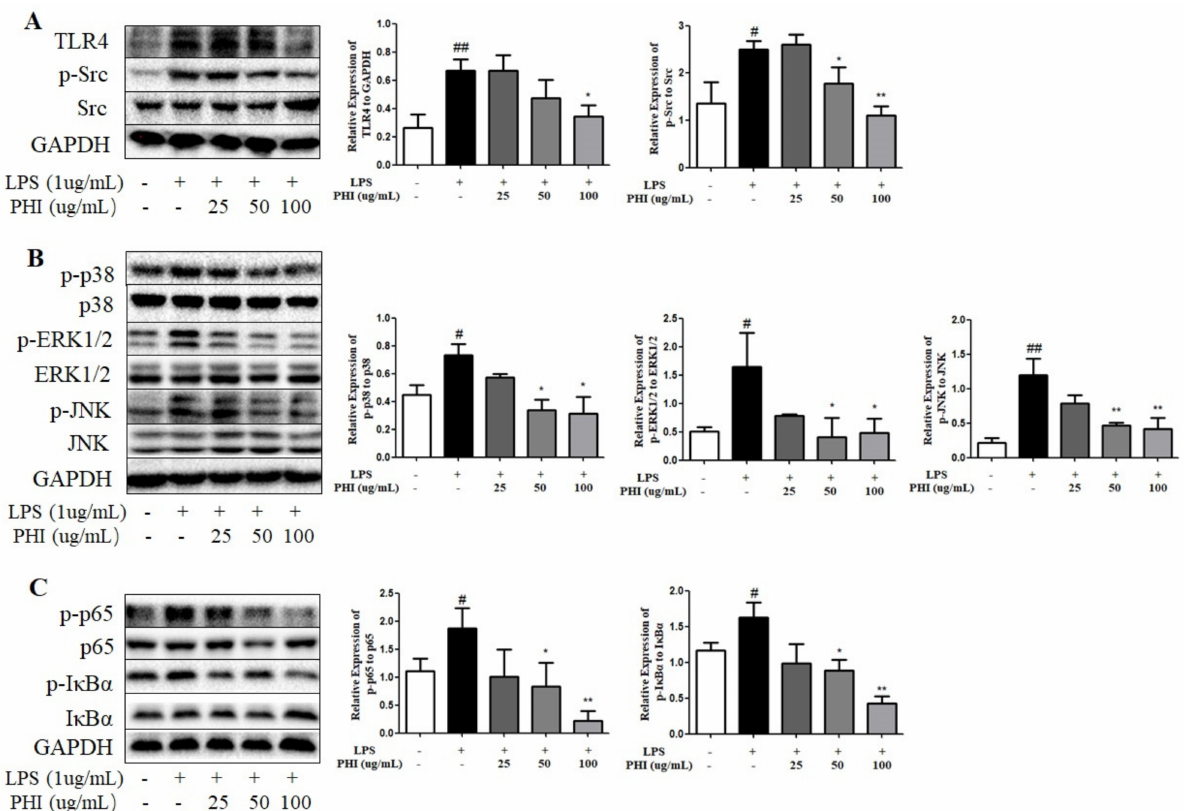
Figure 8. PHI regulated the expressions of TLR4, Src, and downstream NF- κ B and MAPK pathway proteins in LPS-stimulated RAW264.7 cells. ( A ) Protein levels of TLR4, Src, p-Src, ( B ) p38, p-p38, JNK, p-JNK, ERK1/2, p-ERK1/2, ( C ) p65, p-p65, I κ B α , and p-I κ B α in RAW264.7 cells were detected by Western blotting. # p < 0.05and ## p < 0.01 vs. control group. * p < 0.05and ** p < 0.01 vs. LPS-stimulated group. ( n = 3 per